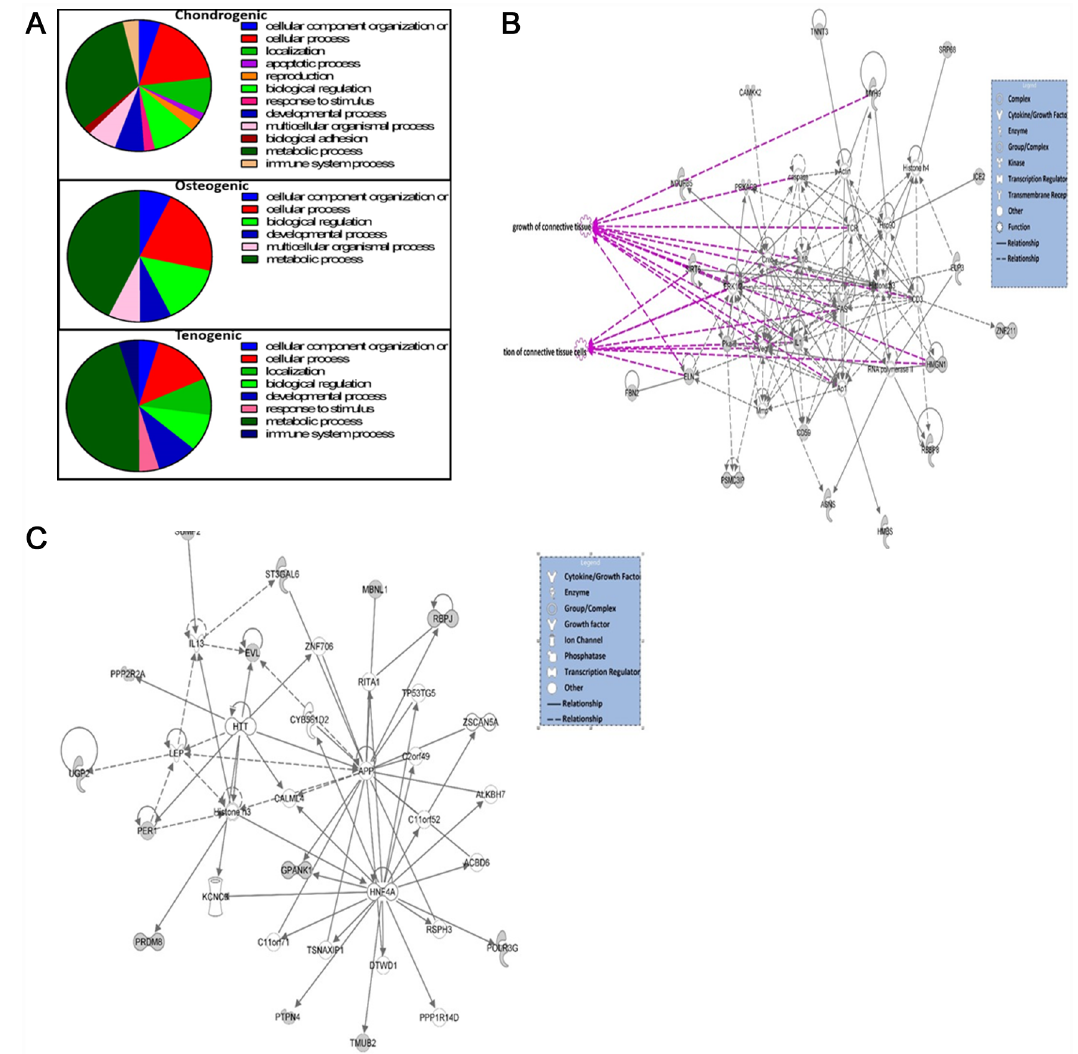
Fig 4. Bioinformatics analysis of AS in engineered tissues. A. Pie charts depicting biological process gene ontology of DE genes in ageing using PANTHER. Genes were demonstrated as DE with ± 1.4 log2 fold change, FDR < 0.05. B. The top scoring IPA derived network for significant AS genes in chondrogenic tissues. This related to ’ cell death and survival, cellular compromise and connective tissue disorders ’ . Significant functions related to the network are overlaid; growth of connective tissue (p = 2.48E-08) and proliferation of connective tissue (p = 6.77E-07). C. The top scoring IPA derived network for significant AS genes in tenogenic tissues was ‘ cell to cell signalling and interaction, cell morphology, function and maintenance ’ . Key to the main features in the networks is shown. Grey nodes were those identified as significant from the AS gene dataset, white nodes genes not in dataset.